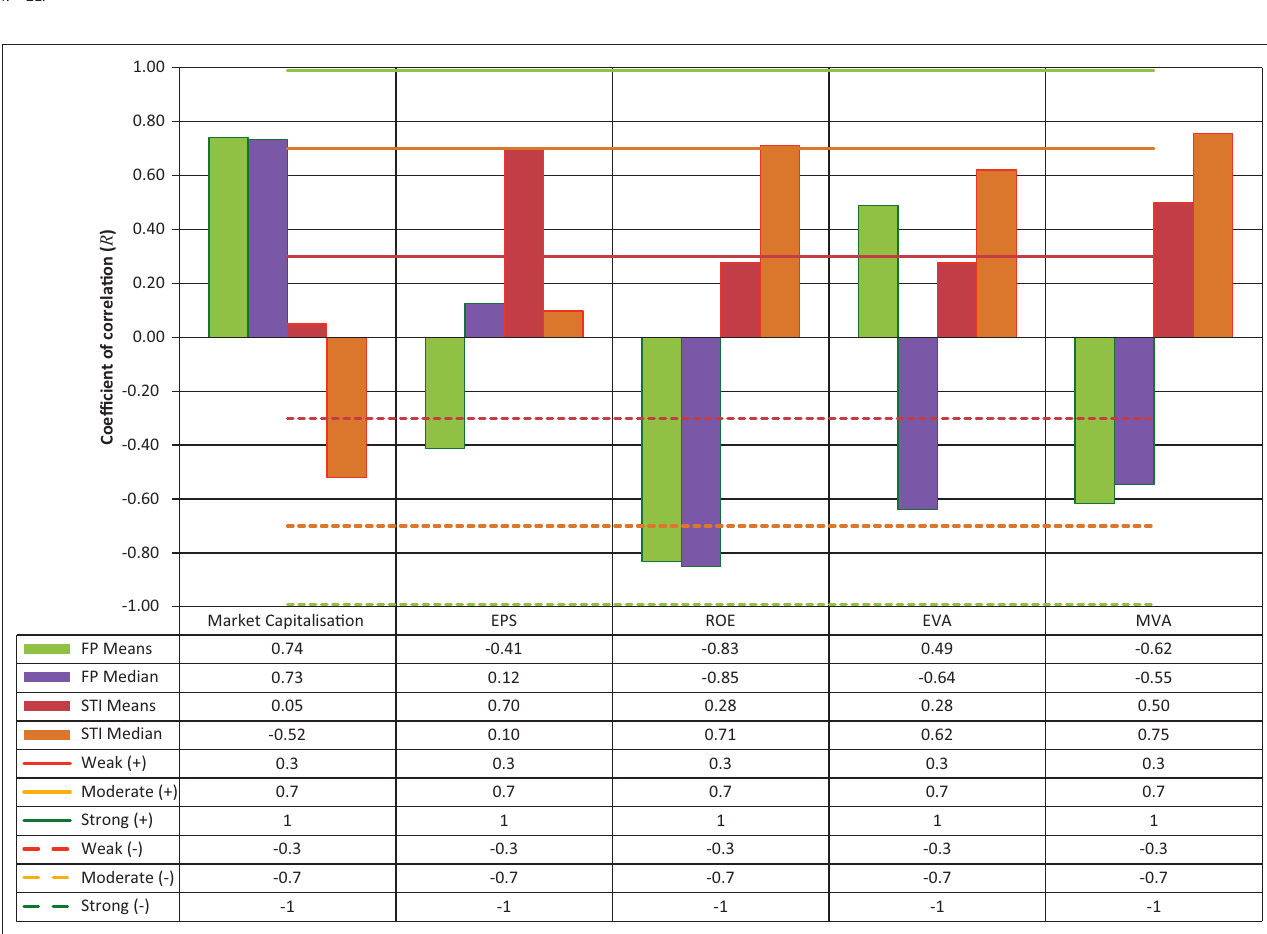
FIGURE 9: Correlation coefficients results: Means and